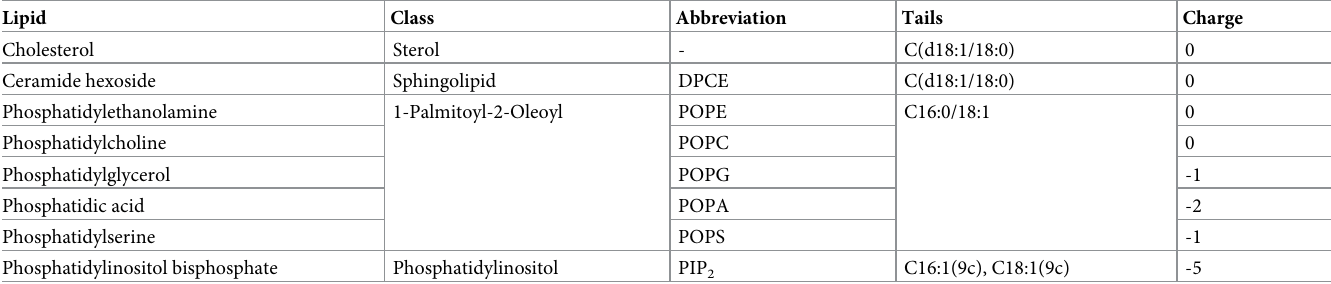
Table 1. Details of the lipids used in the